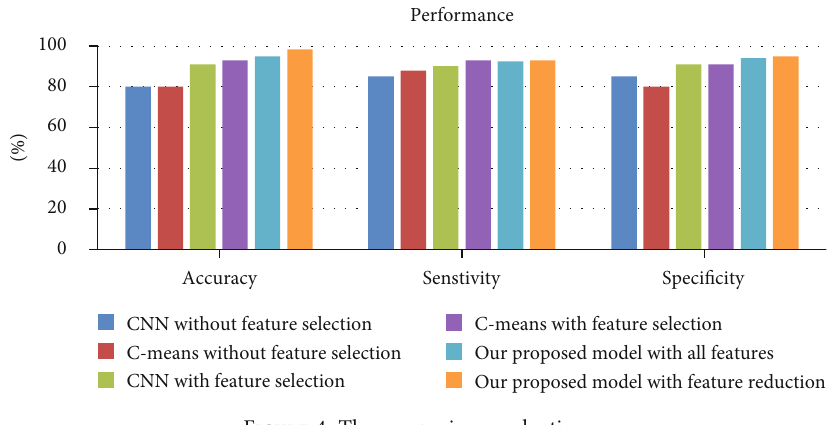
Figure 4: The comparison Table 5: Statistics for using CNN model and C -means with and without feature selection and our QGH algorithm with fuzzy C -means.